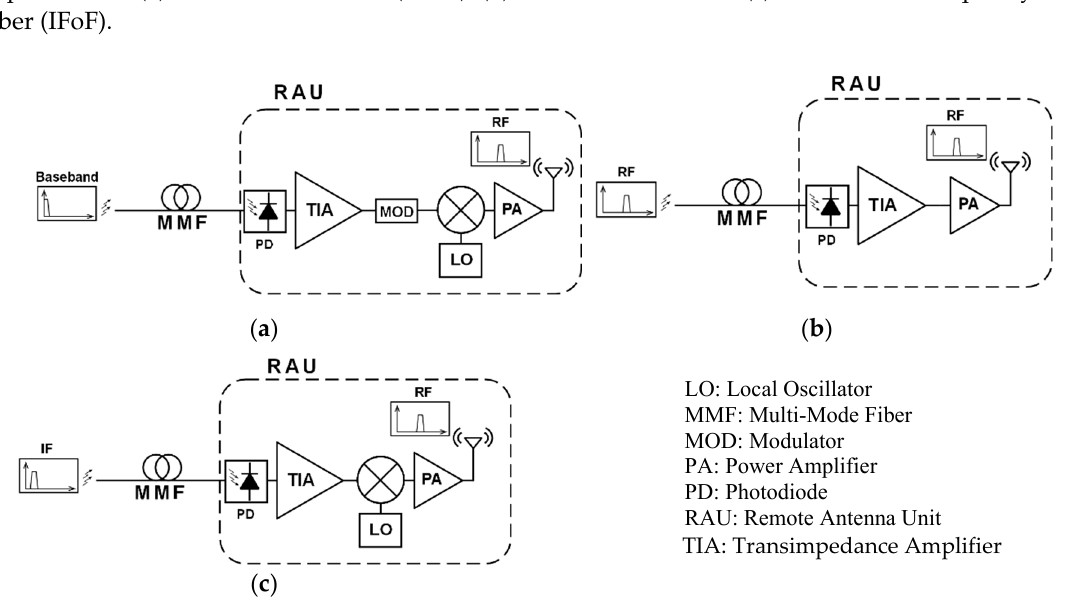
Figure 2. Conceptual scheme of the downlink of remote antenna units for ( a ) baseband over fiber, ( b ) radio over fiber, and ( c ) intermediate-frequency over fiber.